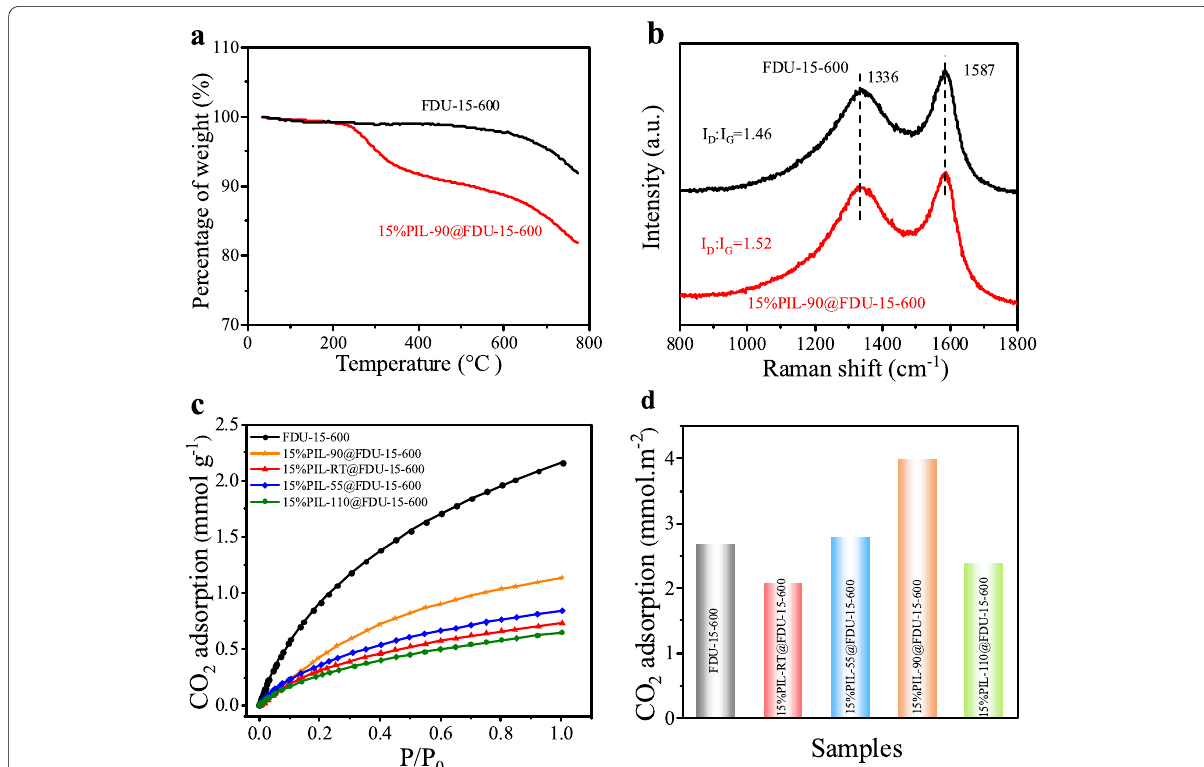
Fig. 4 a TG curves of FDU-15-600 and 15%PIL-90-60@FDU-15-600. b Raman spectra of FDU-15-600 and 15%PIL-90@FDU-15-600. c CO2 adsorption isotherms at 298 K and d Unit adsorption